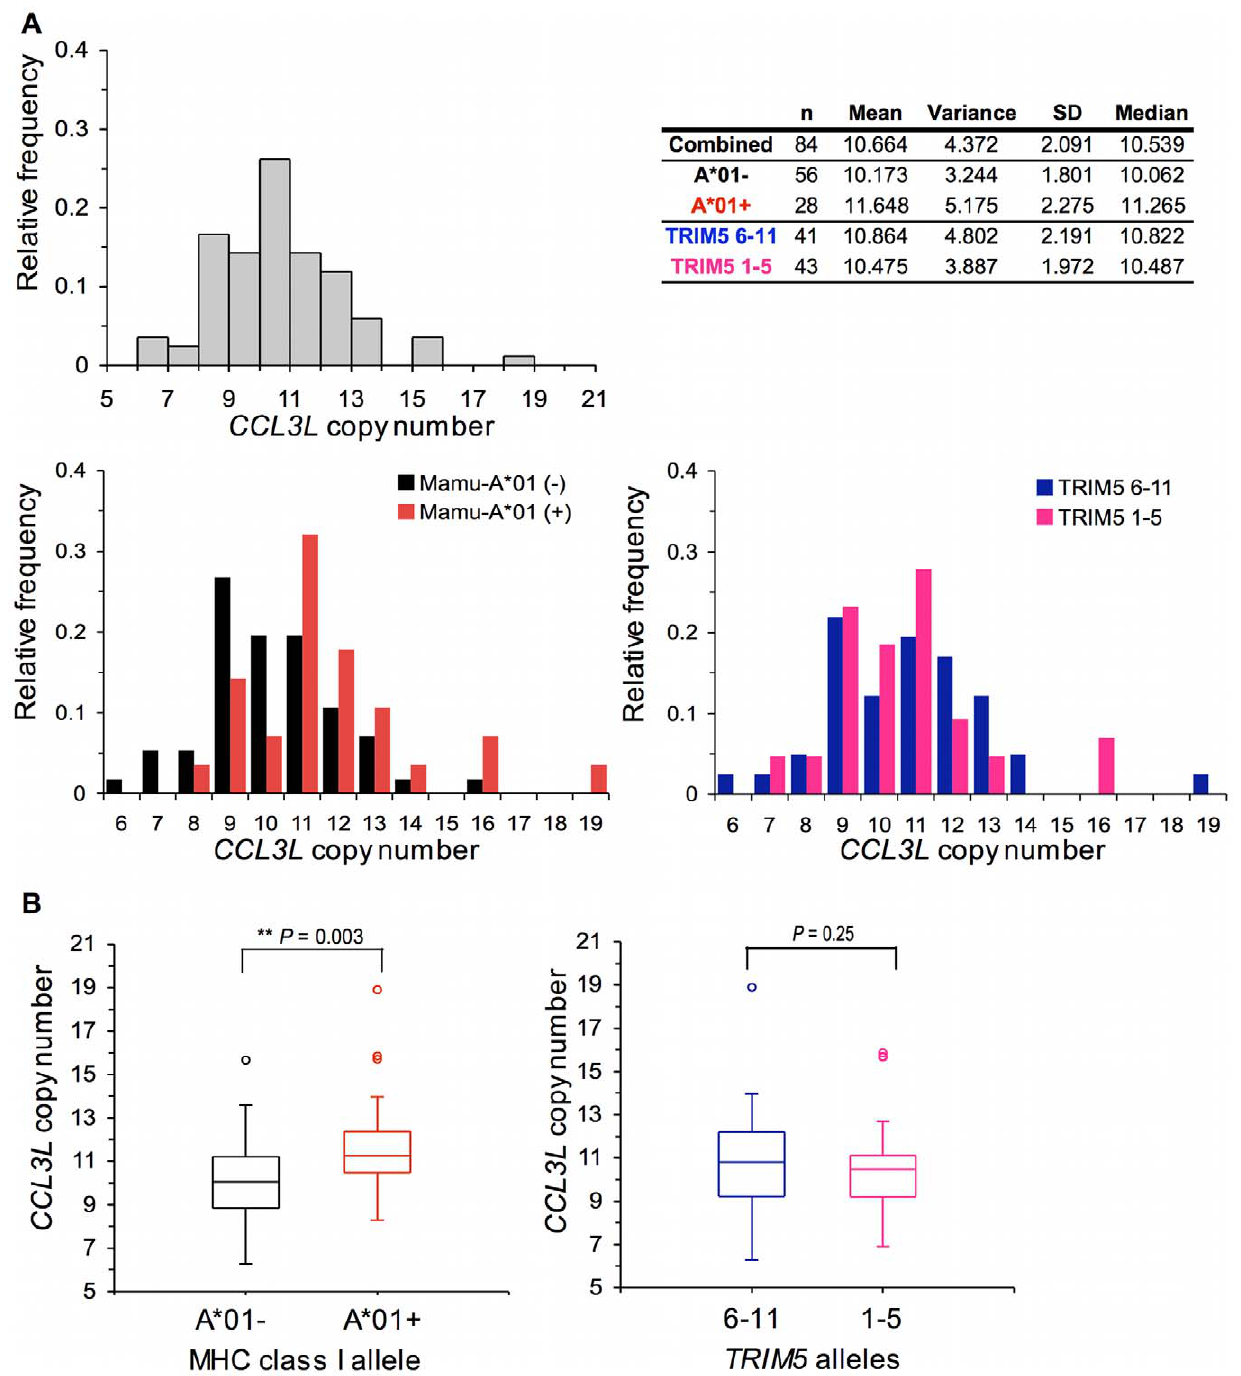
Figure 2. Distribution of CCL3L copy number in Indian-origin rhesus monkeys. Copy numbers of CCL3L genes were estimated using real- time PCR in 84 Indian-origin rhesus monkeys. (A) Frequency distribution of CCL3L copy number. Data are displayed three ways; combining all monkeys, dividing the monkeys into 2 cohorts: one Mamu-A*01 2 and the other Mamu-A*01 + , or dividing the monkeys into 2 cohorts: one of animlas expressing only TRIM5 alleles 1–5 and the other of animals expressing at least 1 TRIM5 allele of the groups 6–11. The mean, variance, standard deviation (SD) and median of the copy number are shown. (B) Boxplots of CCL3L copy number in Mamu-A*01 2 and Mamu-A*01 + animals, and, in one of animlas expressing only TRIM5 alleles 1–5 and the other of animals expressing at least 1 TRIM5 allele of the groups 6–11. The comparisons were analyzed using the Mann-Whitney U test (two-tailed). doi:10.1371/journal.pgen.1000997.g002 Mamu-A*01 and one of TRIM5 alleles from the group of allele 6– not significant (using a linear regression) for either log peak plasma 11 was the CCL3L copy number coefficient significant, but the SIV RNA levels or log set-point plasma SIV RNA levels for most number of monkeys in that group was very small (n= 3) (Table 3). of these subgroups. Only for the group of monkeys that expressed